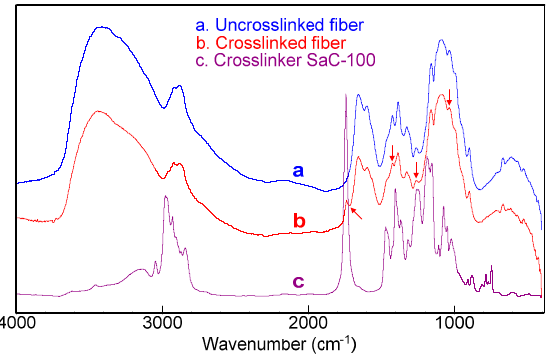
Figure 3. Fourier transform infrared (FT-IR) spectra of the uncrosslinked chitosan fiber ( a ), the crosslinked chitosan fiber ( b ) and Crosslinker SaC-100 ( c ).